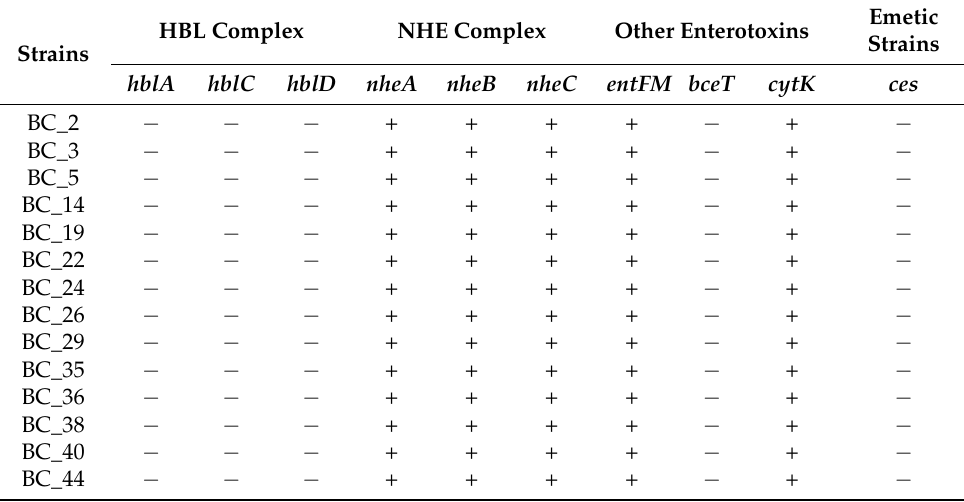
Table 3. Toxin profile of Bacillus cereus isolates included in the study. Results +/ − indicate presence or absence of genes